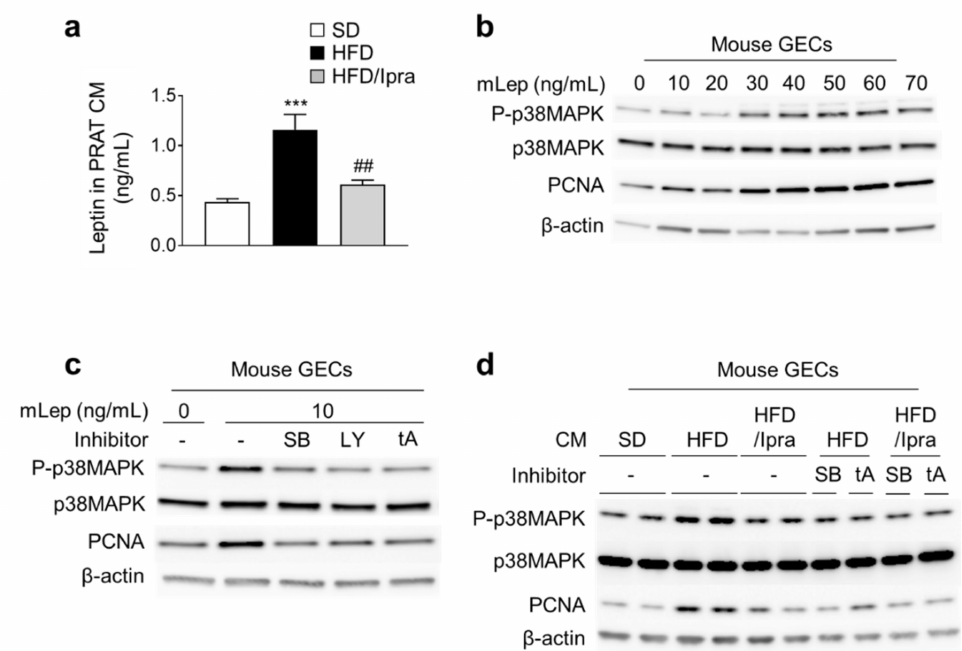
Figure 5. Ipra suppresses leptin secretion from PRAT and proliferative signaling in mouse GECs. ( a ) Leptin concentrations in conditioned media (CM) made from PRAT. ( b ) Western blotting of phosphorylated and total p38 mitogen-activated protein kinase (p38 MAPK), and proliferating cell nuclear antigen (PCNA) in mouse GECs treated with mouse recombinant leptin (mLep). ( c ) Western blotting of phosphorylated and total p38 MAPK, and PCNA in mouse GECs treated with mLep after pre-incubation with SB203580 (SB), LY294002 (LY), and leptin triple antagonist (tA), which functions as a leptin competitive inhibitor. ( d ) Western blotting of phosphorylated and total p38 MAPK, and PCNA in mouse GECs treated with PRAT-CM after pre-incubation with SB and tA. *** p < 0.001 vs. SD. ## p < 0.01 vs. HFD. n = 6 ( a